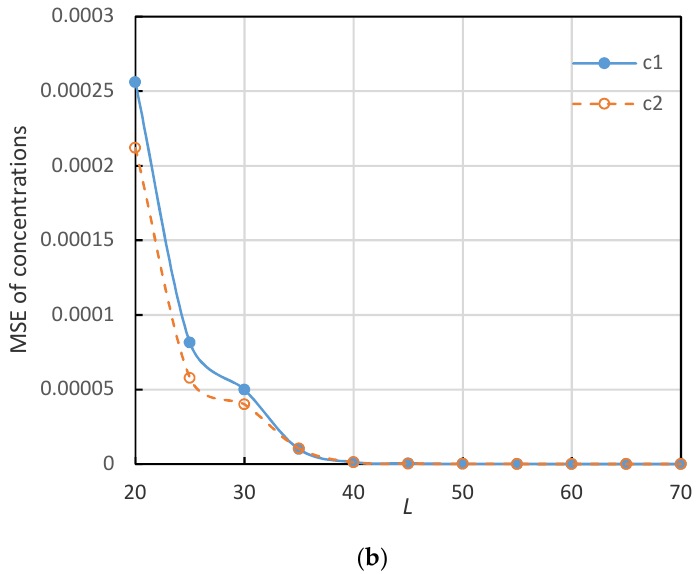
Figure 4. ( a ). The mean squared errors (MSE) of the thickness variation with L (the number of hidden layer nodes). ( b ). The MSE of the concentrations of c 1 , c 2 variation with L (the number of hidden nodes).